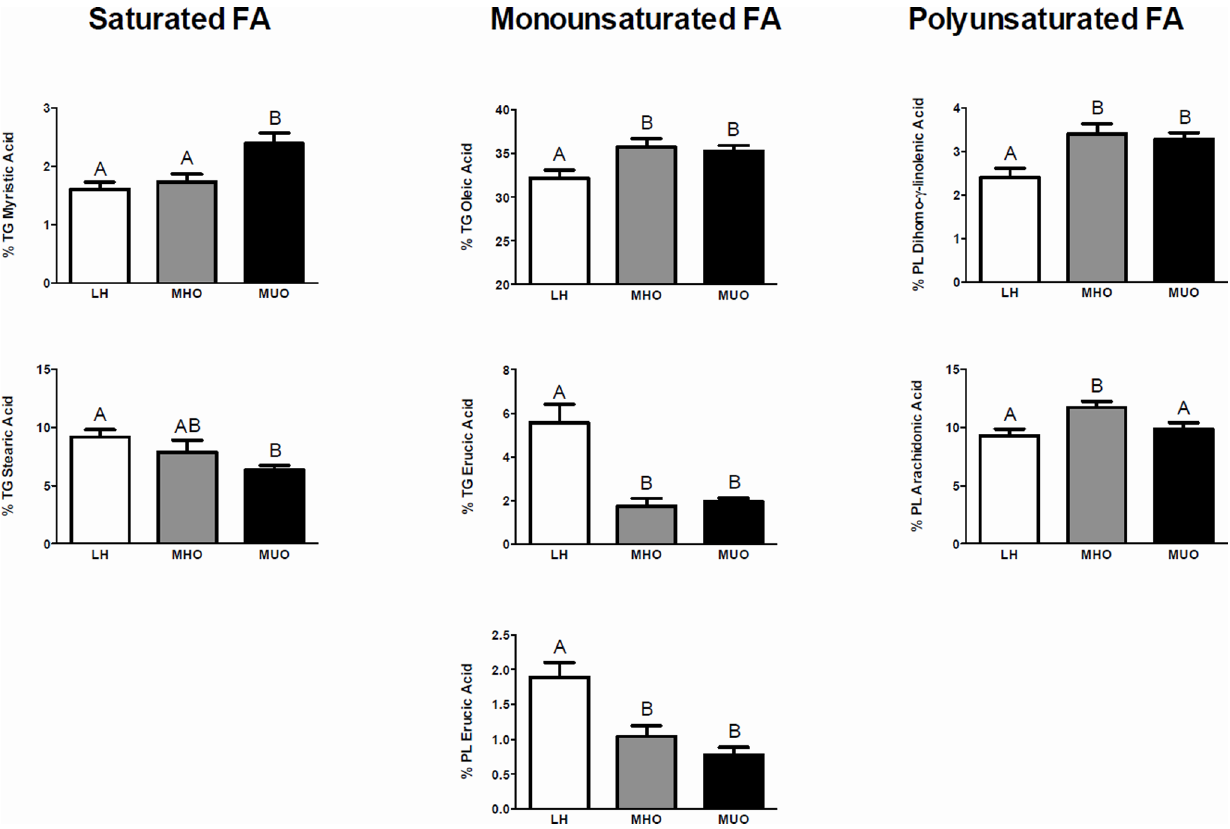
Figure 3. Mean relative percentage values of fatty acids identified in the serum phospholipid and triglyceride fraction. Fatty acids (FAs) meeting a VIP . 1 in our OPLS-DA model were individually assessed between the three groups using a non-parametric ANOVA Kruskal-Wallis test followed by a post-hoc Mann-Whitney-Wilcoxon test. Bars not sharing the same letter are statistically different (P , 0.05). White bars=LH; grey bars=MHO; and black bars=MUO.